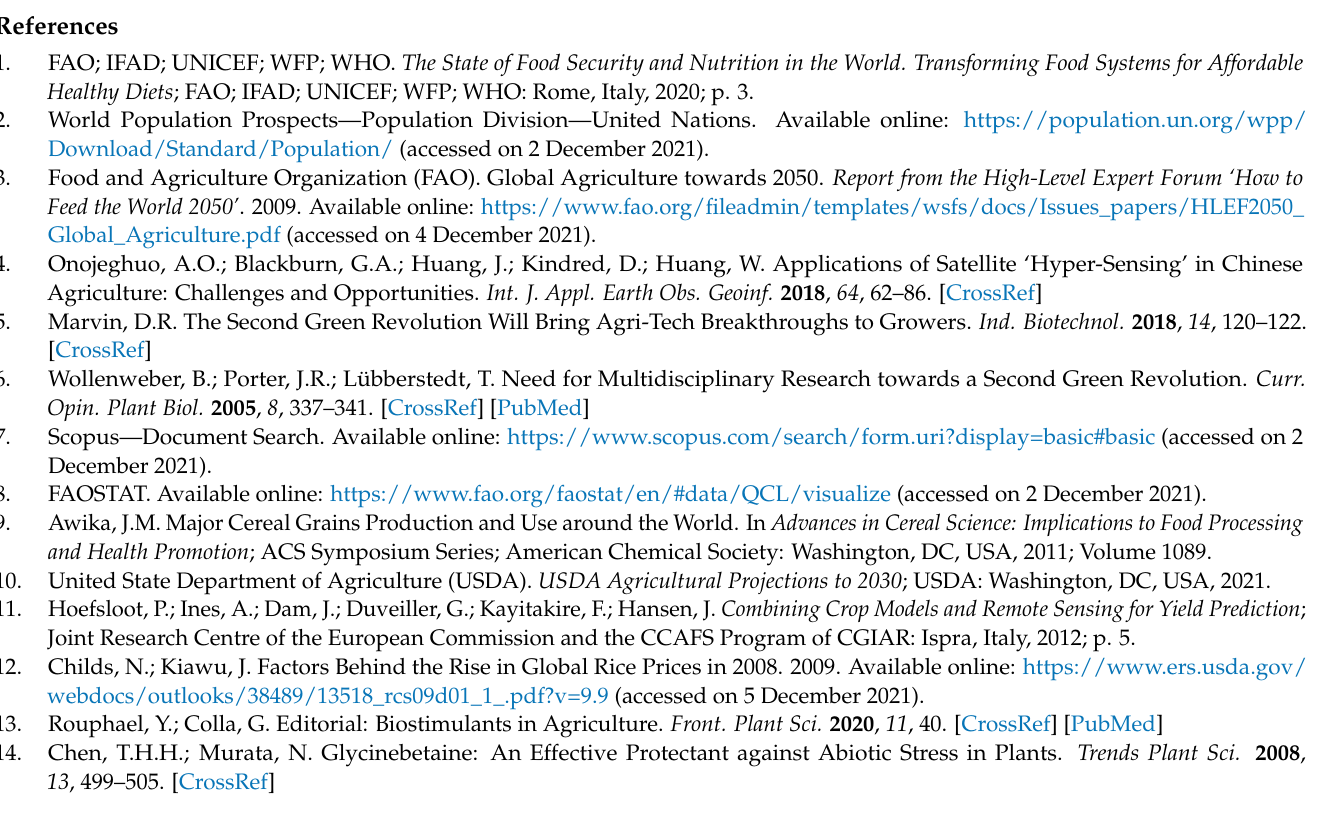
Figure A2. Comparison between VIs and satellites (( A ) Sentinel-2, ( B ) Planet) for the same date. Arrow indicate the proper